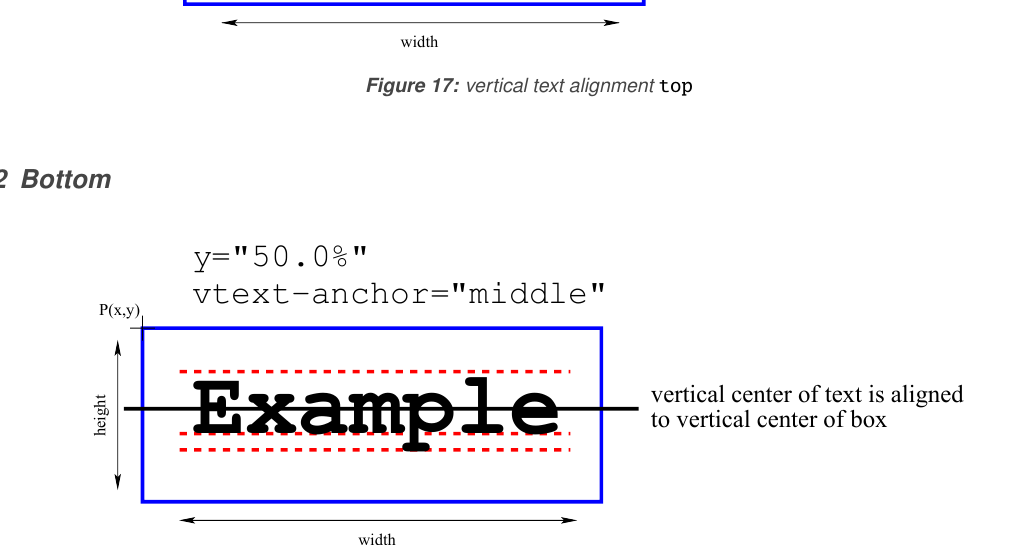
Figure 18: vertical text alignment